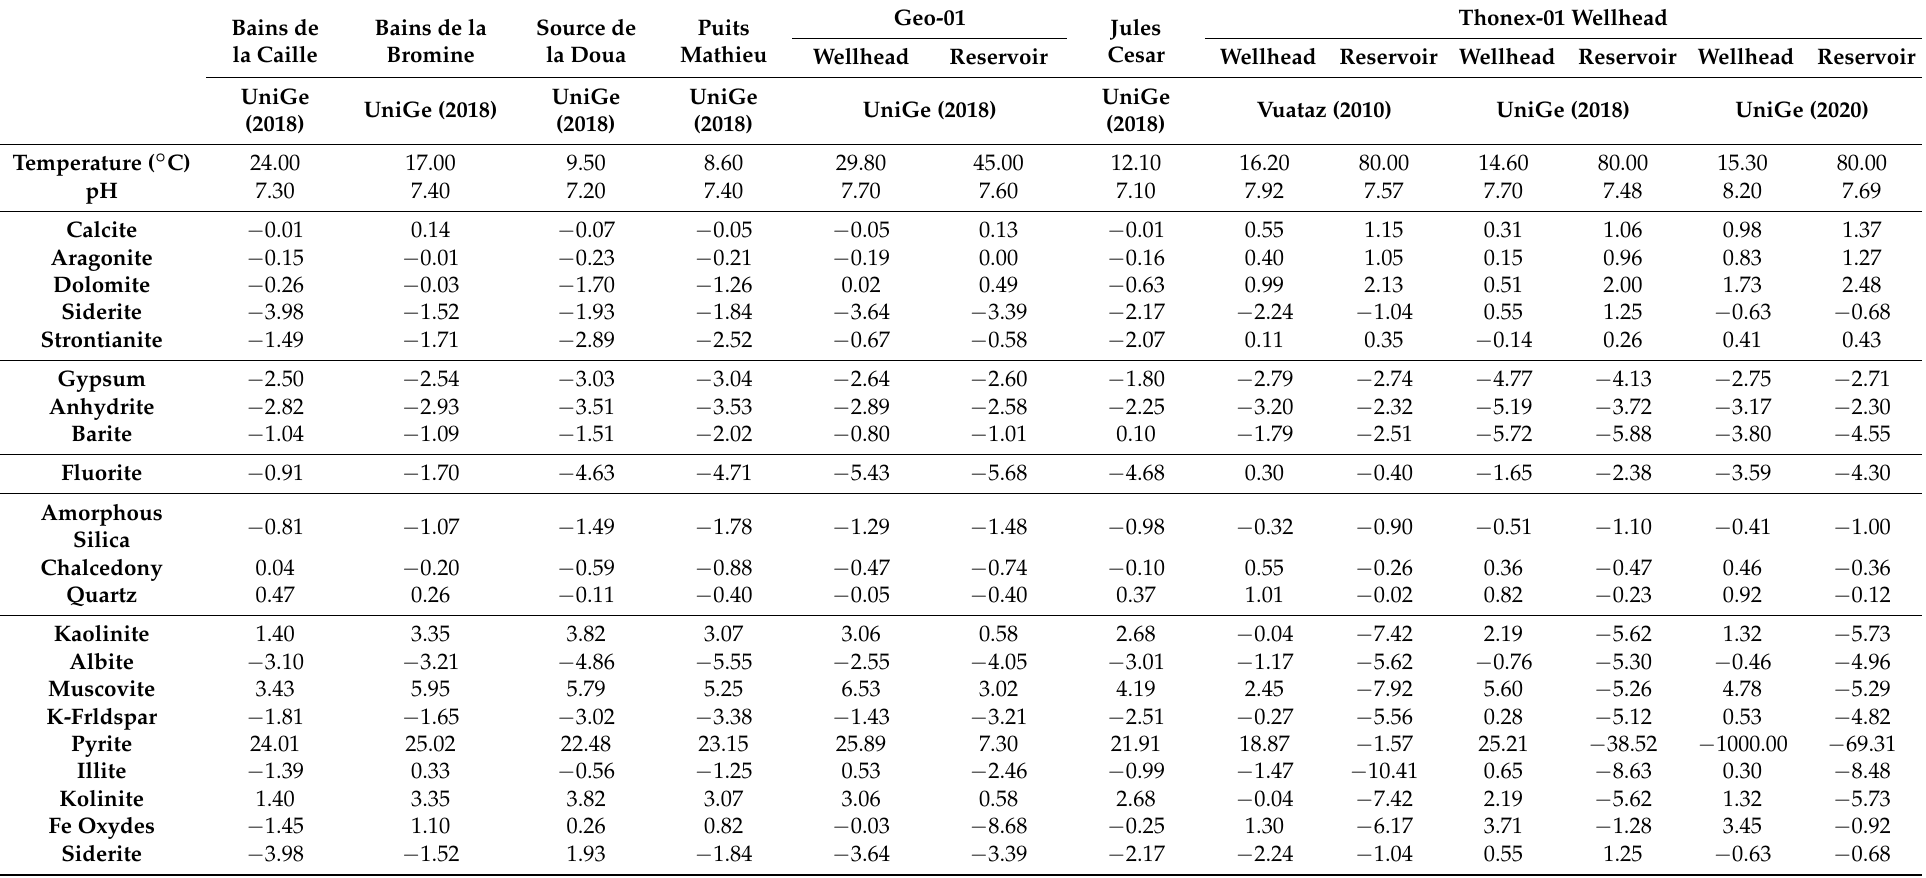
Table 2. Mineral-fluid equilibria at sampled temperature for the analysed